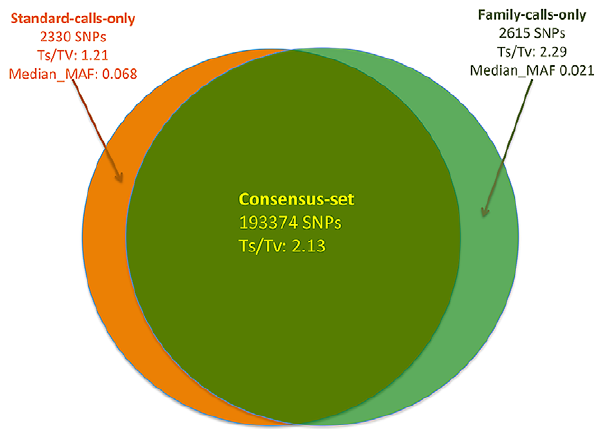
Figure 5. Comparisons of two variant callsets from SardiNIA low-pass sequencing data where variant calling was carried out by explicitly modeling family relatedness (family calls) and by the standard approach of ignoring relatedness (standard calls).